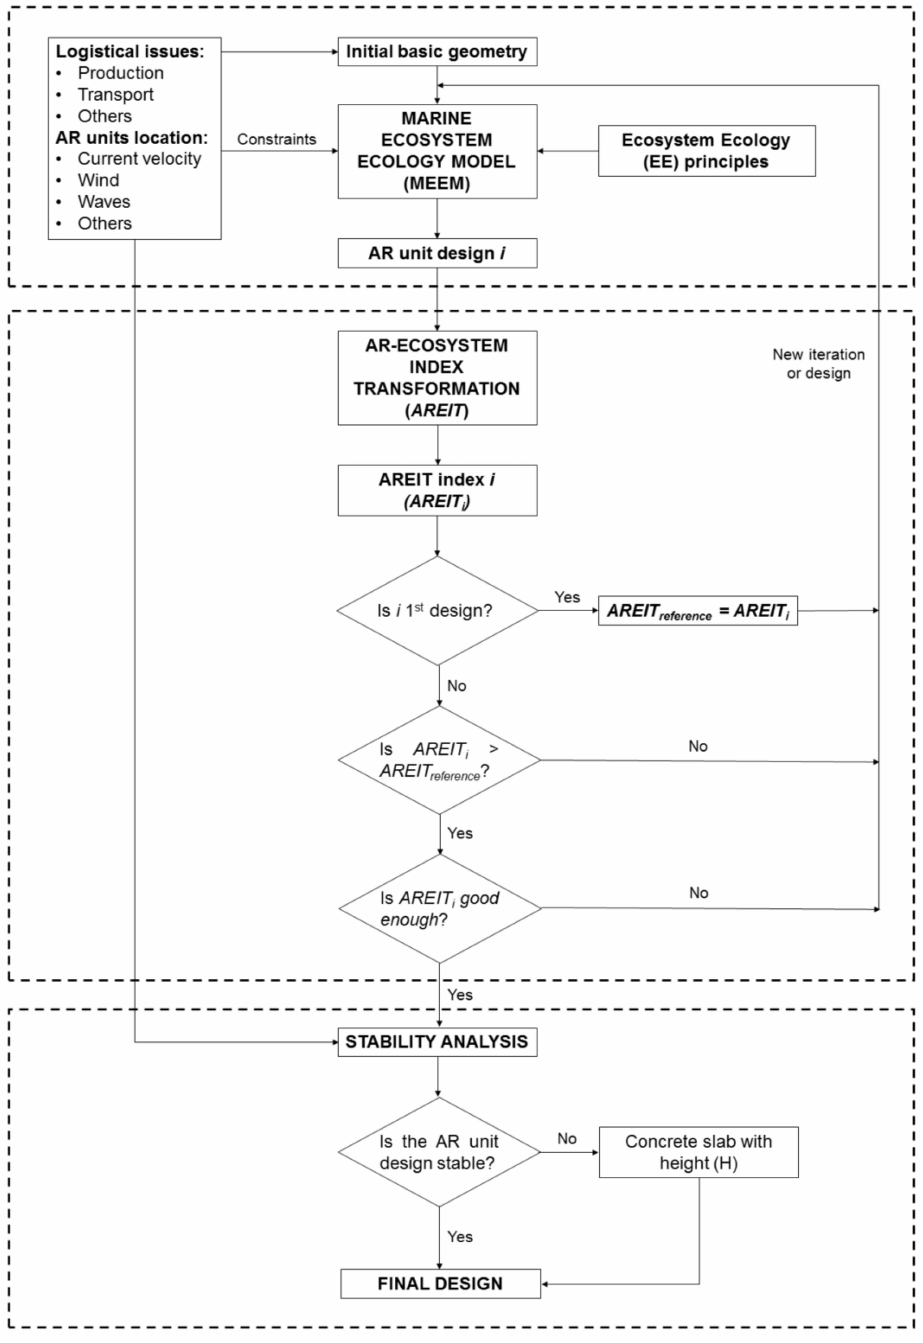
Figure 1. Flowchart of the conceptual framework proposed in this study. The dashed lines separate its three main parts: Marine Ecosystem Ecology Model (MEEM), AR-Ecosystem Index Transformation (AREIT), and the stability